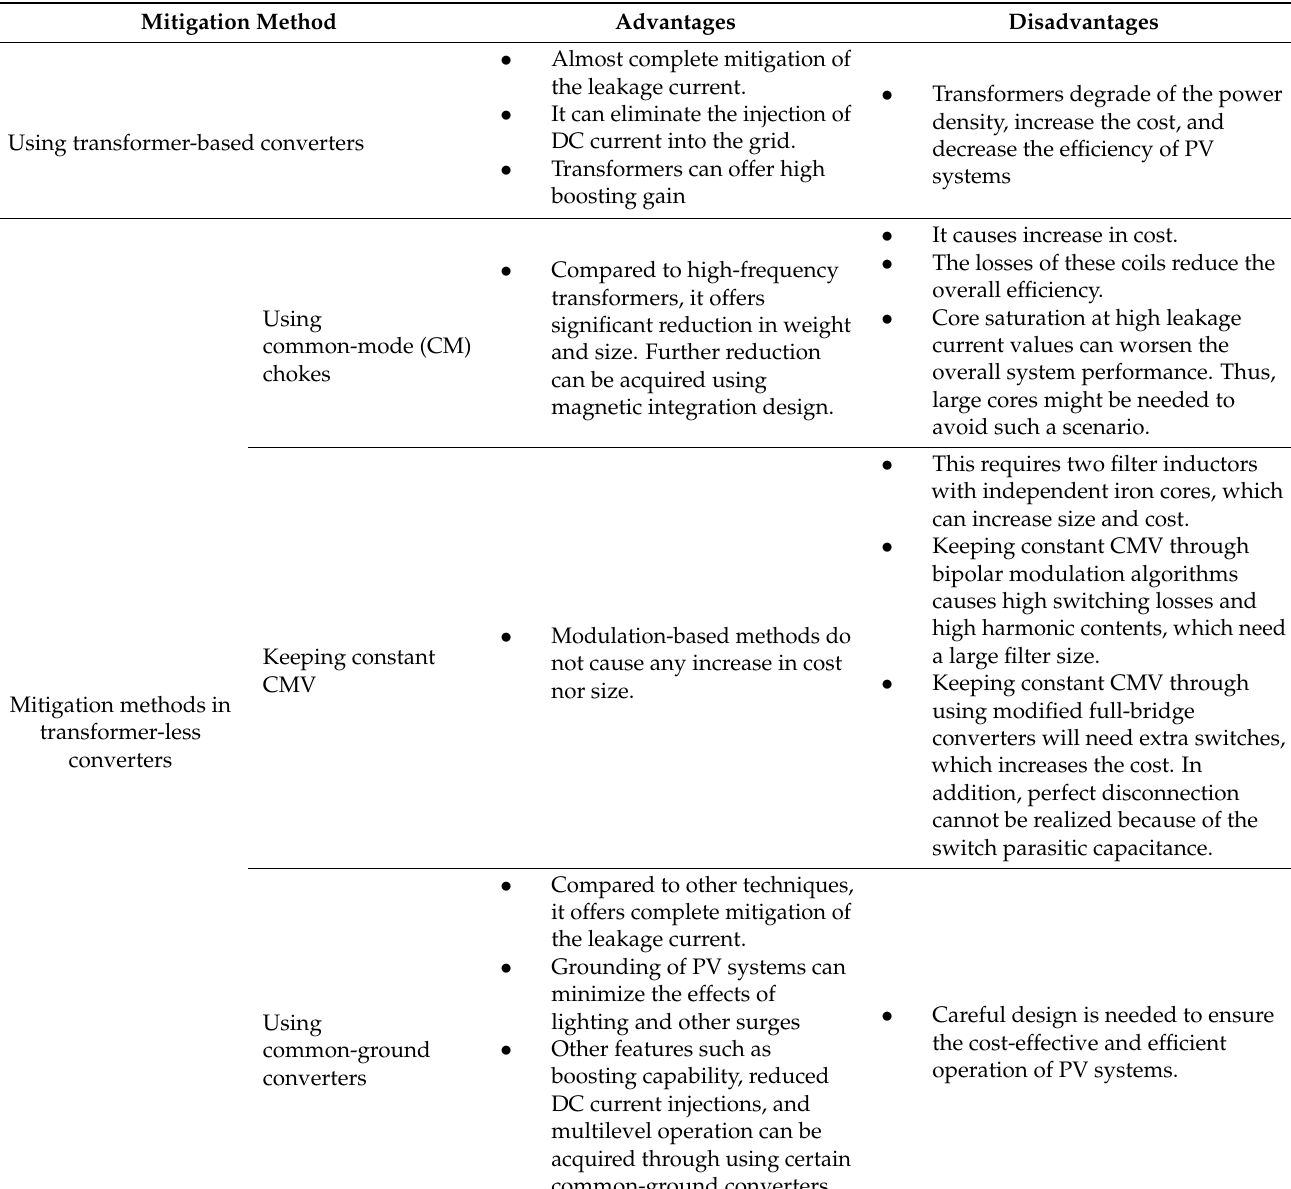
Table 2. Leakage current mitigation